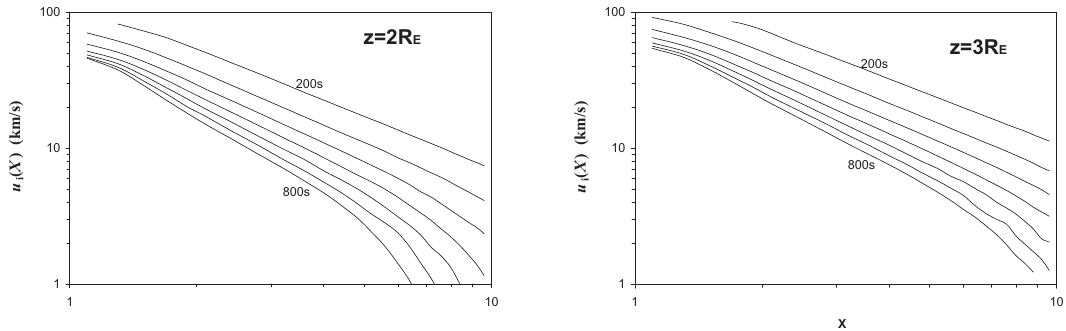
Fig. 13. Evolution of the dispersive patterns of ion upward velocities versus X at two altitudes: 2 R E (left) and 3 R E (right). The curves are displayed from t D = 200s up to t D = 800s with a step of